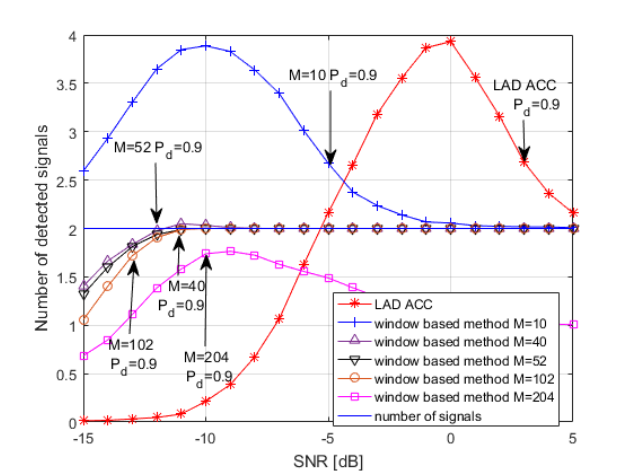
when there is one or d = 0 . 9